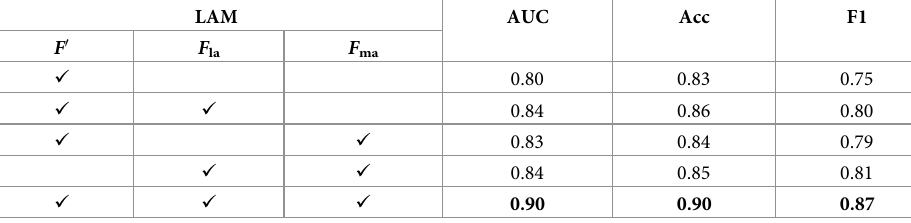
The best results are indicated in boldface. LAM denotes Lesion Attention